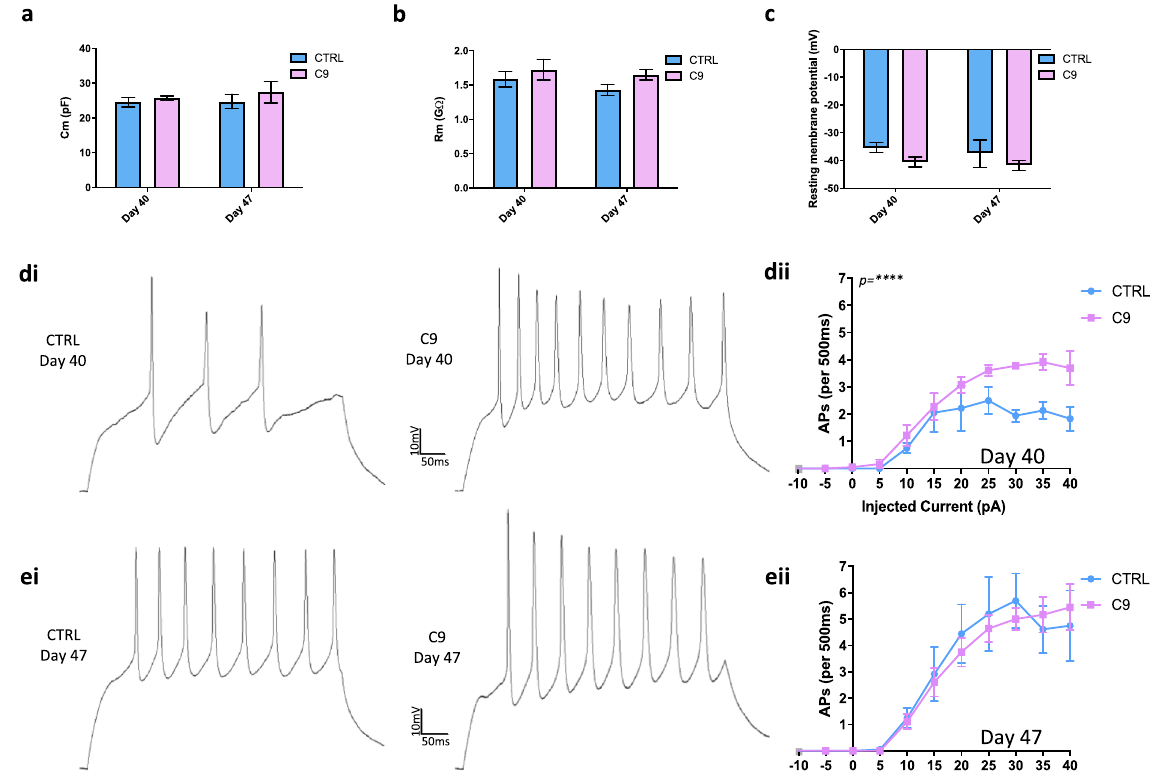
Figure 2. Hyperexcitability is present in young C9ORF72 MNs vs CTRL MNs. Whole-cell patch clamp of iPSC-derived MNs showed that ( a ) membrane capacitance ( C m ), ( b ) membrane resistance ( R m ), and ( c ) resting membrane voltage were not significantly different between C9 and CTRL MNs at day 40 nor at day 47. Two-Way RM ANOVA: p = ns, N = 3 lines, 1–2 differentiations. ( di , ei ) Representative traces of evoked action potential firing. ( dii , eii ) Average action potential firing per 500 ms for each current step (mean ± SEM). Non-linear regression **** p = <